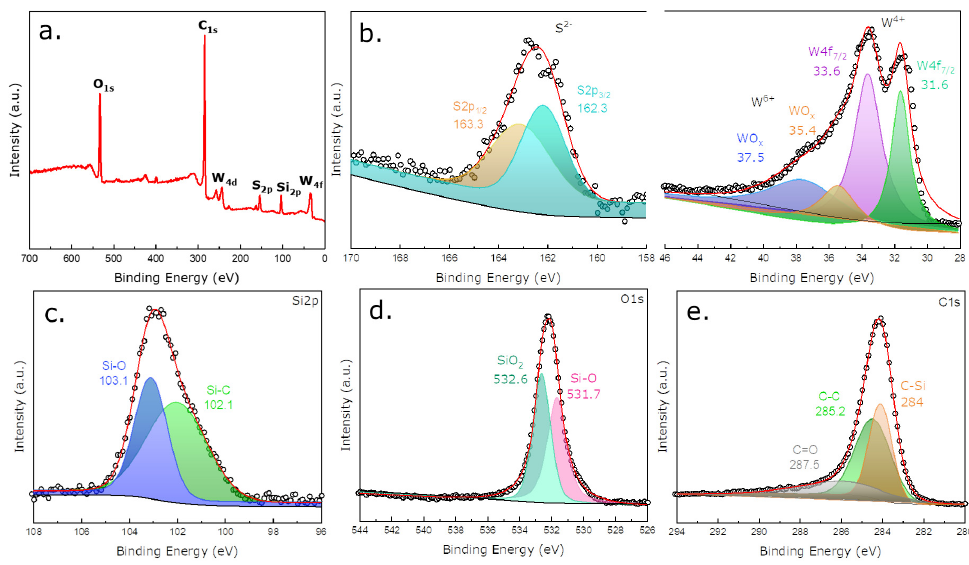
Figure 3. ( a ) XPS survey scan of WS 2 containing SiOC fibermats representing the presence of individual elements after pyrolysis of the fibermat at high temperature; ( b ) High-resolution S2p (L) and W4f (R) XPS spectra of the WS 2 /SiOC fibermat recording the bonding states due to s.o.s. of W and S; High-resolution: ( c ) Si2p XPS spectra; ( d ) O1s XPS spectra; ( e ) C1s XPS spectra obtained from the WS 2 /SiOC fibermat confirming the bonding states of the Si, O and, C, respectively in SiOC